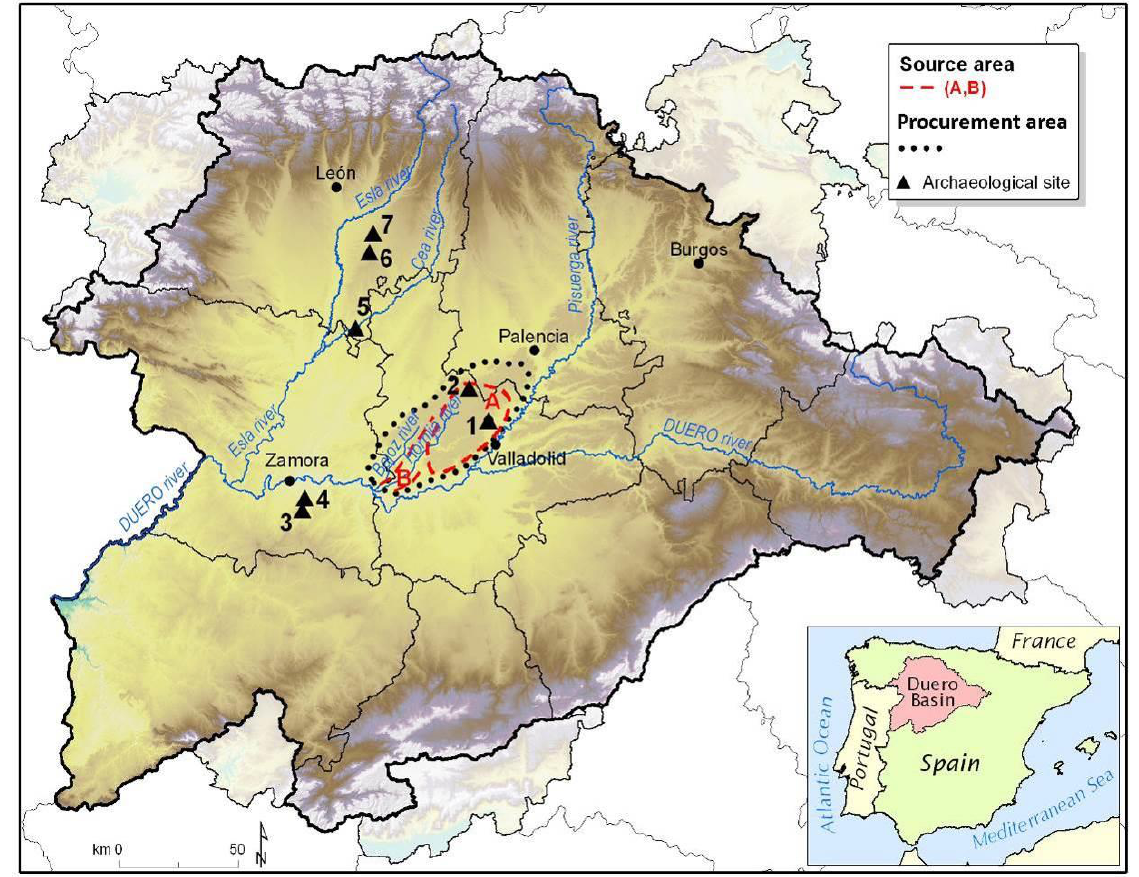
Figure 5. Proposed procurement area for “Mucientes chert”. Archaeological sites where Torozos/Mucientes chert objects have been cited. 1: Los Cercados (Mucientes, Valladolid). 2: El Casetón de la Era (Villalba de los Alcores, Valladolid). 3: Canchal de Jambrina (Peleas de Abajo, Zamora). 4: Las Pozas (Casaseca de las Chanas, Zamora). 5: Los Villares (Valderas, León). 6: Los Palomares (Fontanil de los Oteros, León). 7: Las Choperas (Santas Martas,